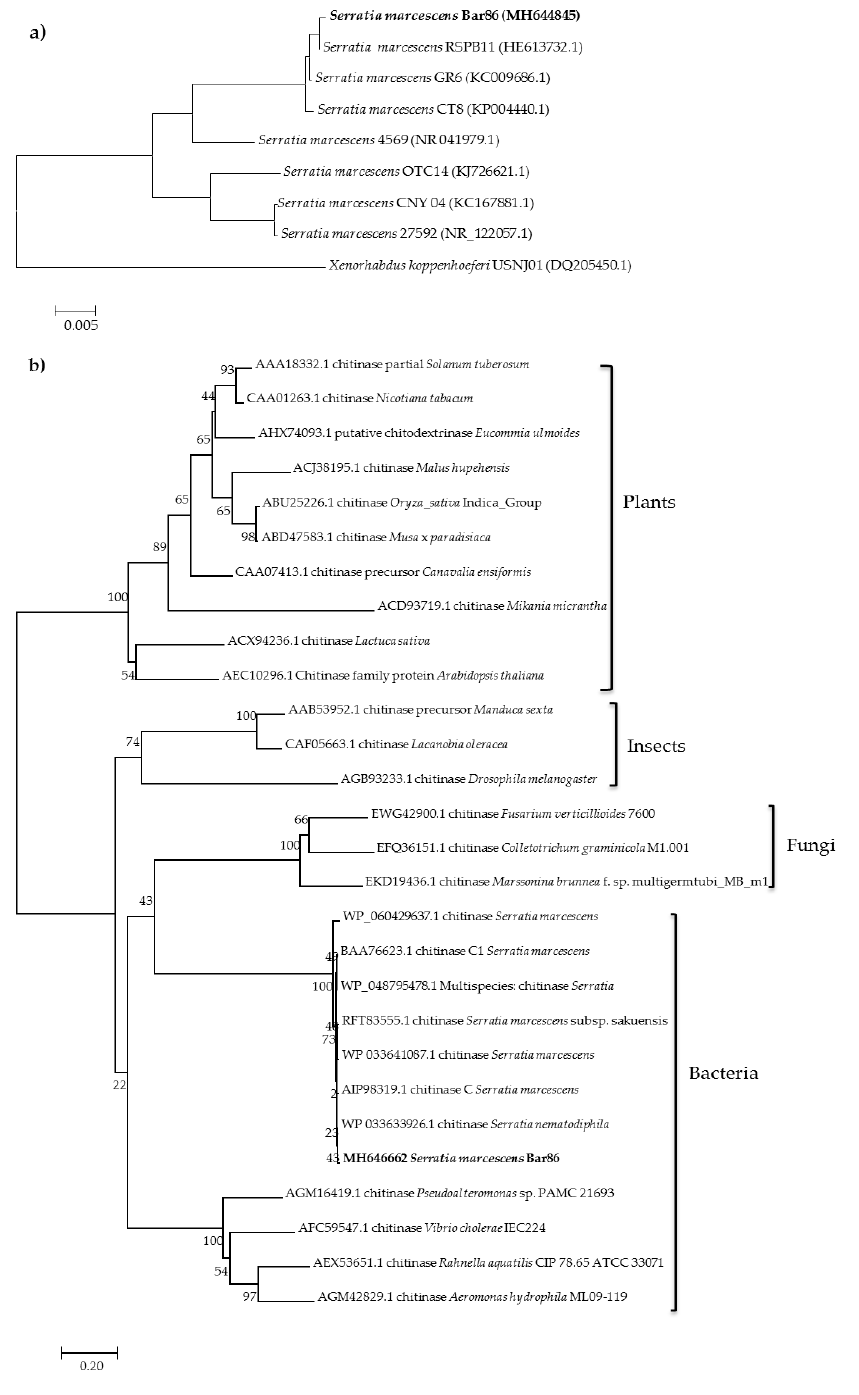
Figure 1. Phylogenetic analysis. ( a ) Relationships showing the relatedness of 16S rDNA between the new isolate of Serratia marcescens Bar86 and selected reference isolates derived from the GenBank database. ( b ) Phylogenetic tree of deduced SmChiC amino acid sequences with chitinases from plants, insects, fungi and bacteria.